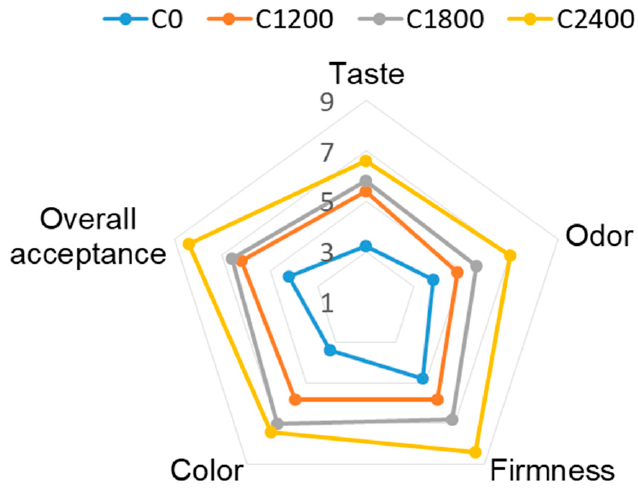
Figure 5. Radar plots showing the effect of GelA/CNCs-CEO coatings loaded with different CEO concentrations (1200–2400 µ L/L) on the sensory characteristics of ‘ Red Delicious ’ apples after 60 days of cold storage at 4 °C. Numbers indicate the averaged score attributed by panelists to each parameter upon the hedonic test.